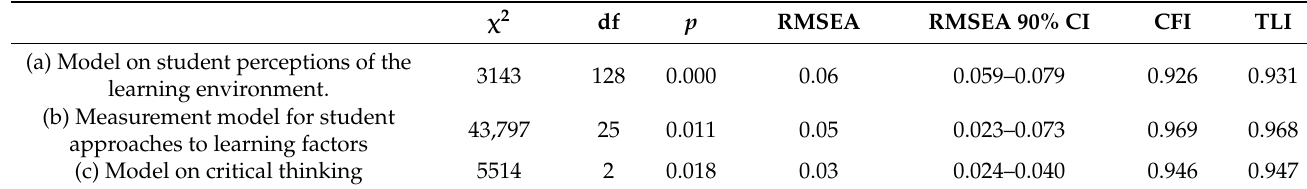
Figure 4. Proposed original model with all dimensions included. Table 1. Goodness-of-fit indices for the models